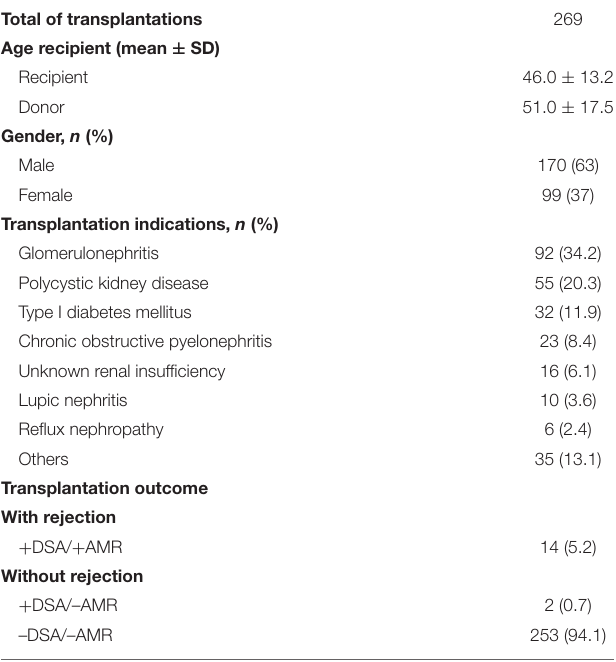
TABLE 1 | Demographic data and main kidney transplantation